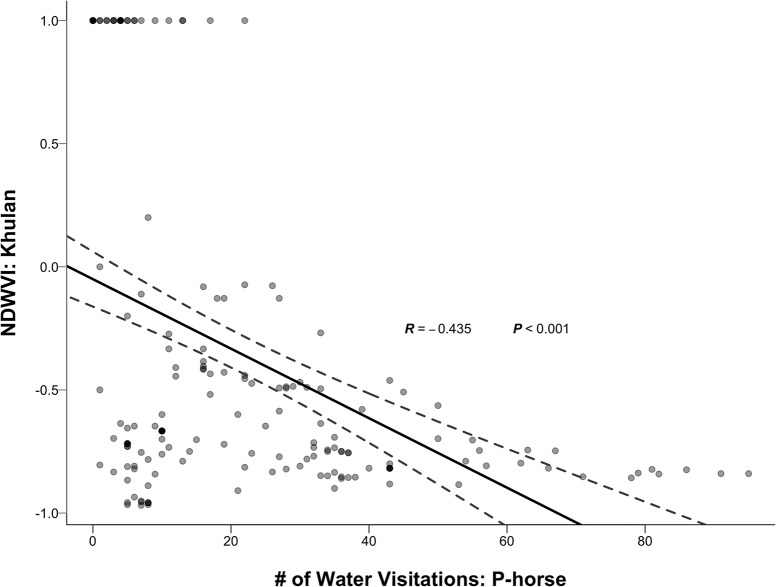
The number of water visitations by P-horse negatively affected the circadian pattern of water use (NDWVI) by Khulan at W02, the water point disproportionally used by both species.The grey-scaled scatter point represented each observation within 10-day sliding window. All scatter points were transparent so that overlapped points would be darker in the plot. A linear regression line (solid) was fit to the dataset with the 95% Confidence Intervals (dashed).